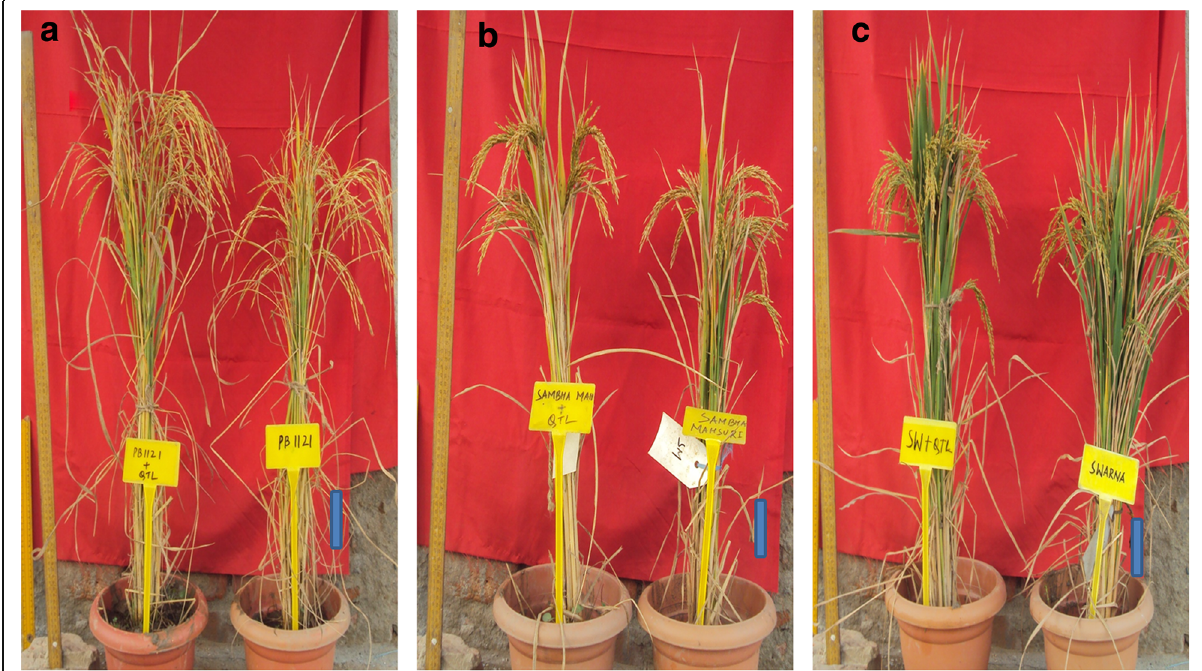
Fig. 3 Plant architecture of qGN4.1 QTL-NILs (left side) of rice as compared to their recipient parents (right side): a Pusa Basmati 1121(PB1121) b Samba Mahsuri c Swarna (scale bars: 10